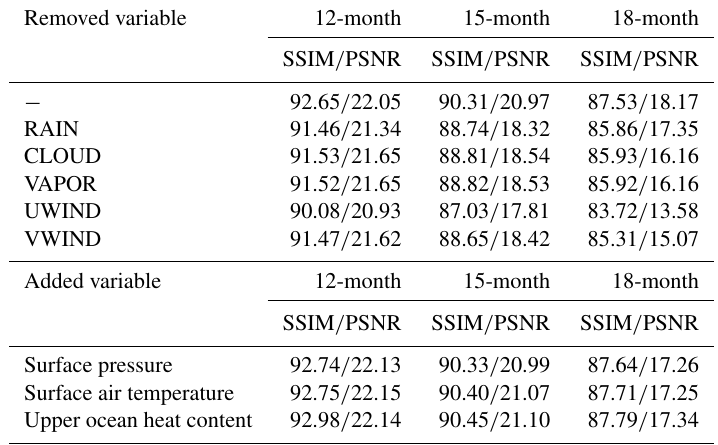
Table 3. Model performance when one existing variable is removed or one extra variable is